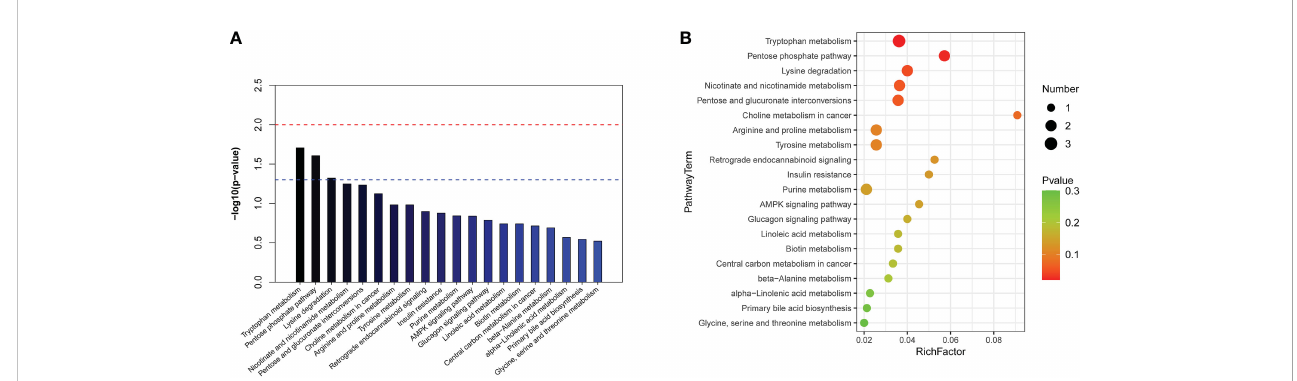
FIGURE 4 The signi fi cantly enriched pathways involved in total patients. (A) Top-20 metabolic pathway enrichment map.The red line indicates a P value of 0.01, and the blue line indicates a P value of 0.05. When the top of the bar is higher than the blue line, the pathway is considered to be signi fi cant. (B) Top-20 bubble chart. The colour changed from green to red indicates that signi fi cance increases in turn; the larger the point is, the greater the number of metabolites enriched in the